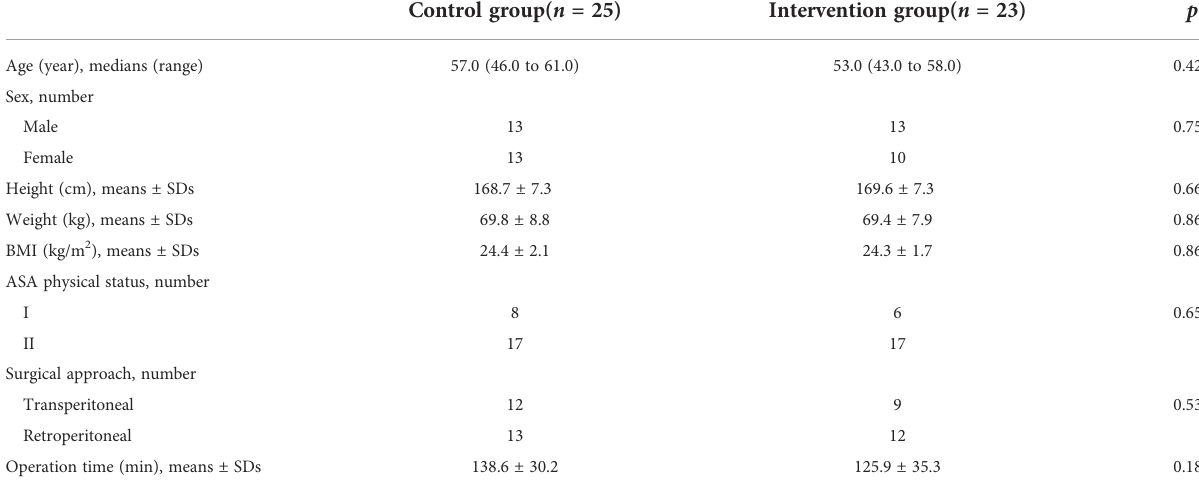
TABLE 1 Baseline and surgical